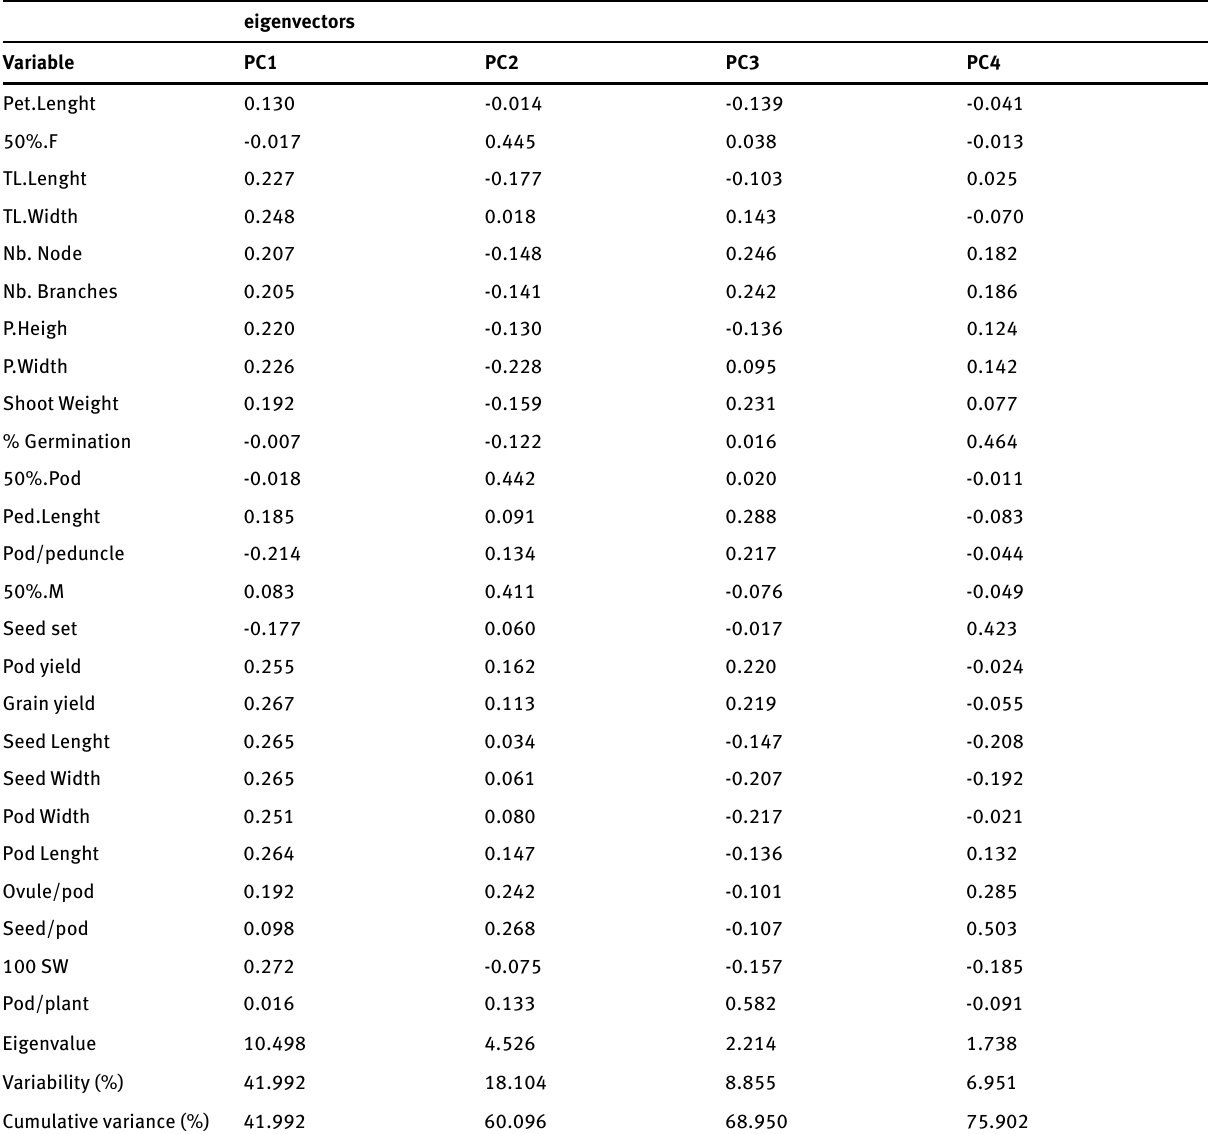
Table 8: Eigenvectors and eigenvalues of the first four principle components for 25 quantitative traits of 30 accessions of cowpea ( Vigna unguiculata